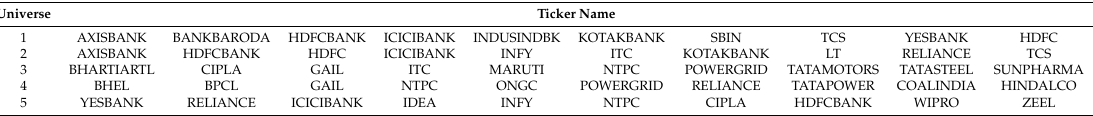
Table A1. Ticker name of the constituents of each of the universes constructed for our study.